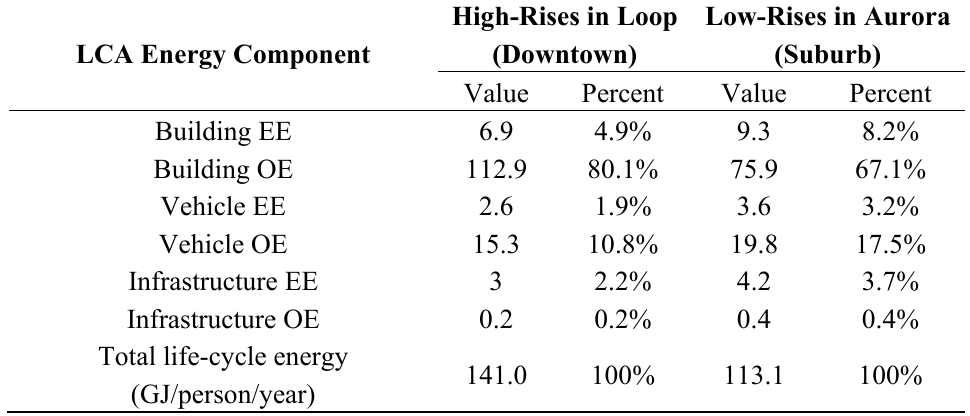
Table 10. Annual life-cycle energy (GJ/person/year) associated with residential life in high-rises in the downtown Chicago Loop and low-rise residences in suburban Aurora,